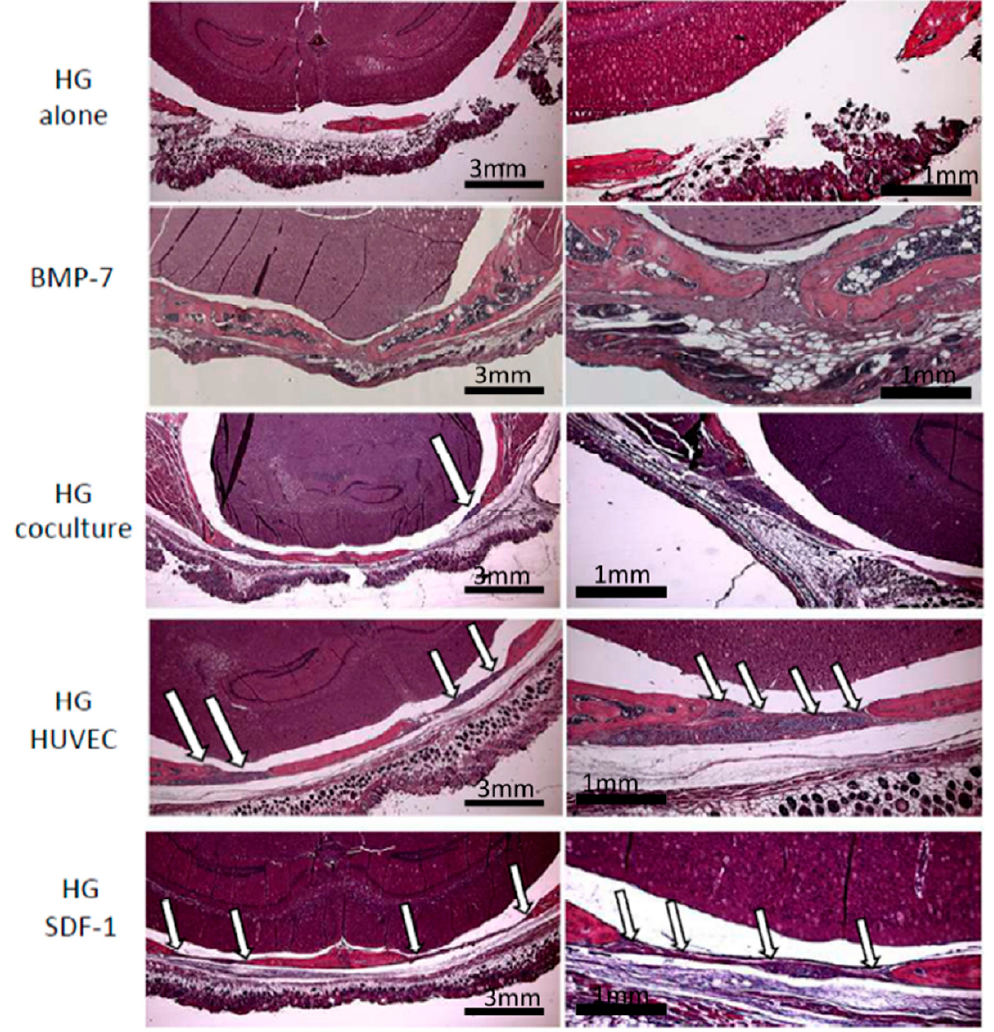
Figure 3. Hematoxylin-eosin (HE) staining of the calvarial defects after treatment with dextran-based hydrogels modified with cells, BMP-7, or SDF-1. Arrows indicate newly formed bony structures and viable cells visible in the HUVEC and SDF-1 groups as well as in the co-culture group, though to a lower extent.